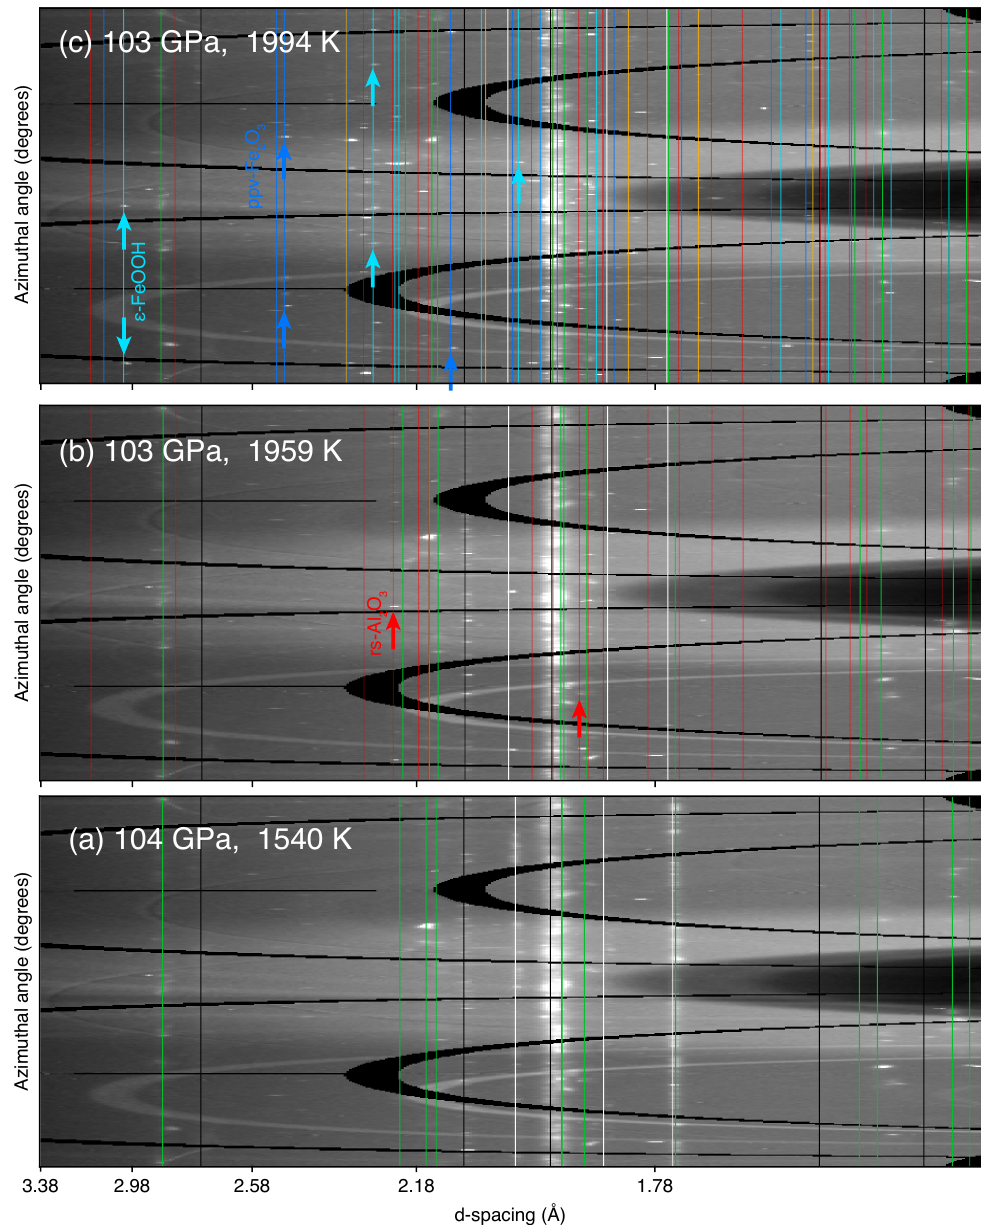
Figure A2. X-ray diffraction images for run #131, where dehydration of δ -AlOOH occurs at 1954 K showing the formation of rs-Al 2 O 3 . X-ray energy was 30 keV. ( a ) At 1540 K, precursor materials (i.e., δ -AlOOH, Ar and Au) as well as W (see Text for details) are present; ( b ) at 1959 K, new lines appear, which can be indexed as rs-Al 2 O 3 ; ( c ) at 1994 K, metallic iron contained in the starting material is found to react with released H 2 O and produce (cid:101) -FeOOH and ppv-Fe 2 O 3